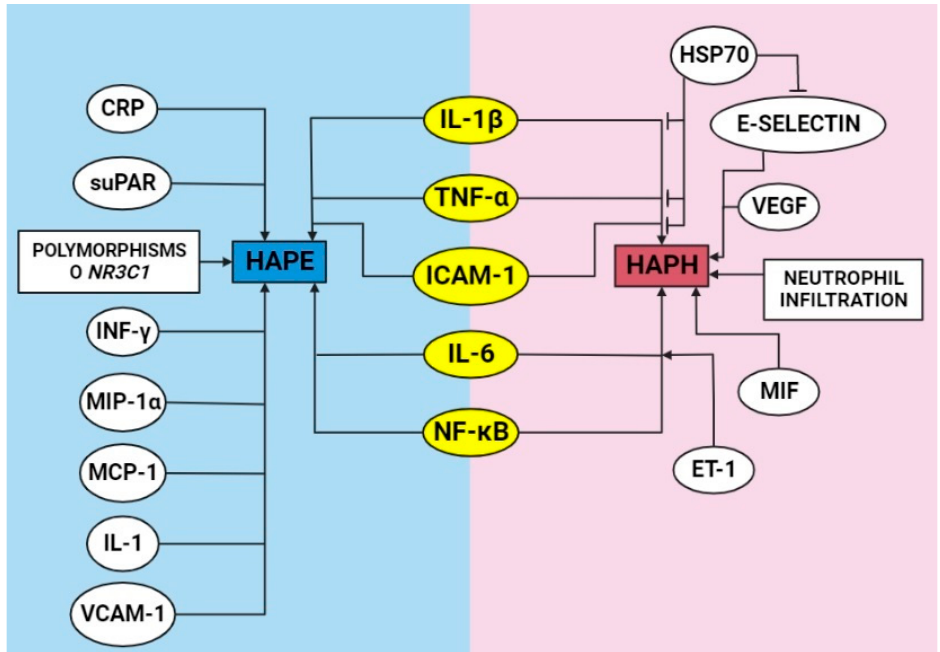
Figure 3. Schematic depiction of the proposed the inflammatory molecules and alterations involved in the development of high-altitude pulmonary edema (HAPE) and high-altitude pulmonary hypertension (HAPH). Created with BioRender.com.